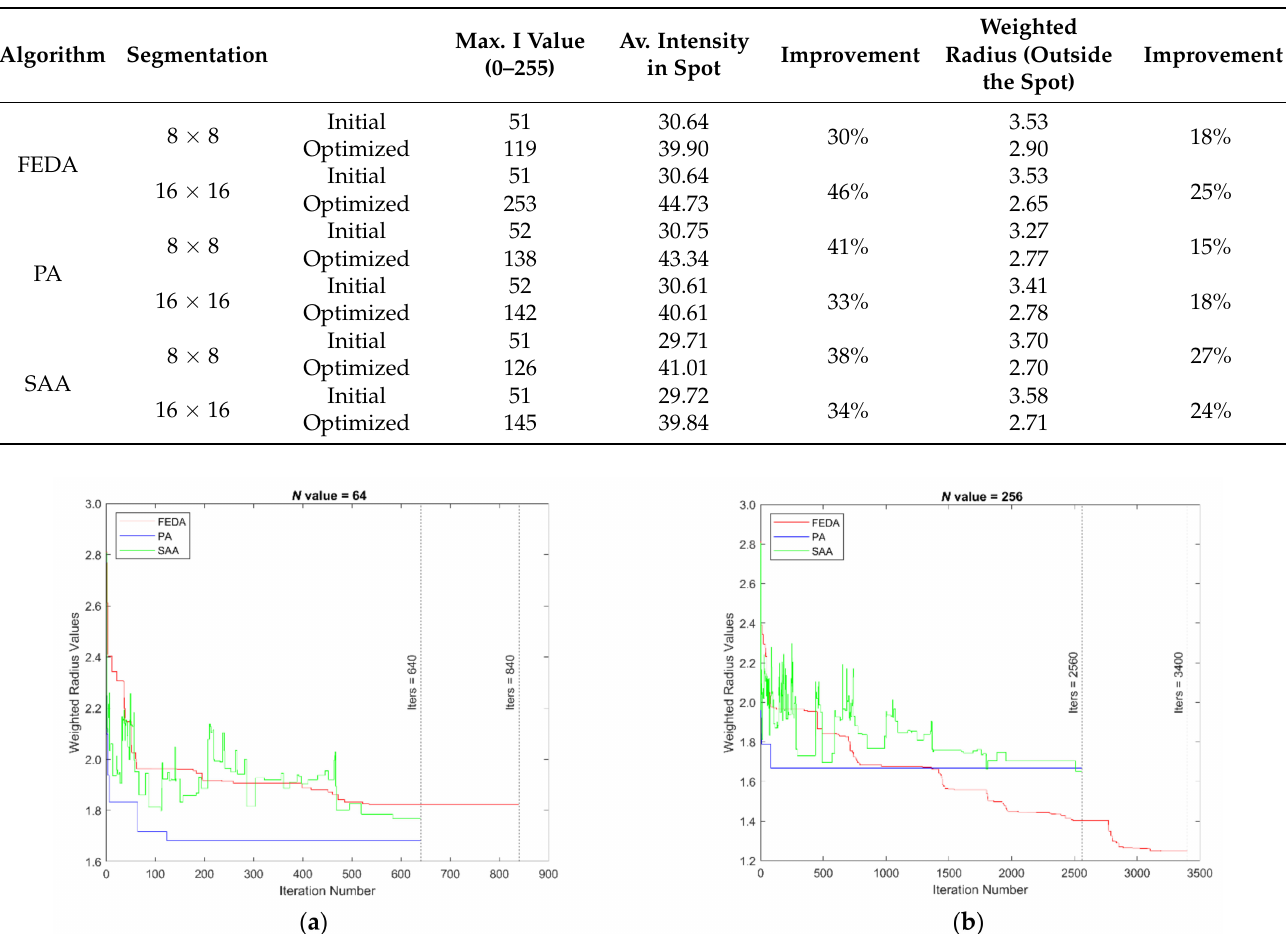
Table 2. Measurements for the weighted radius optimization.